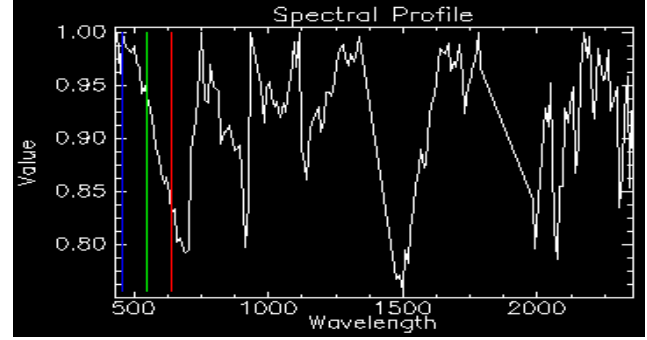
Figure 6. Spectral Profile of Build-up area with radiance